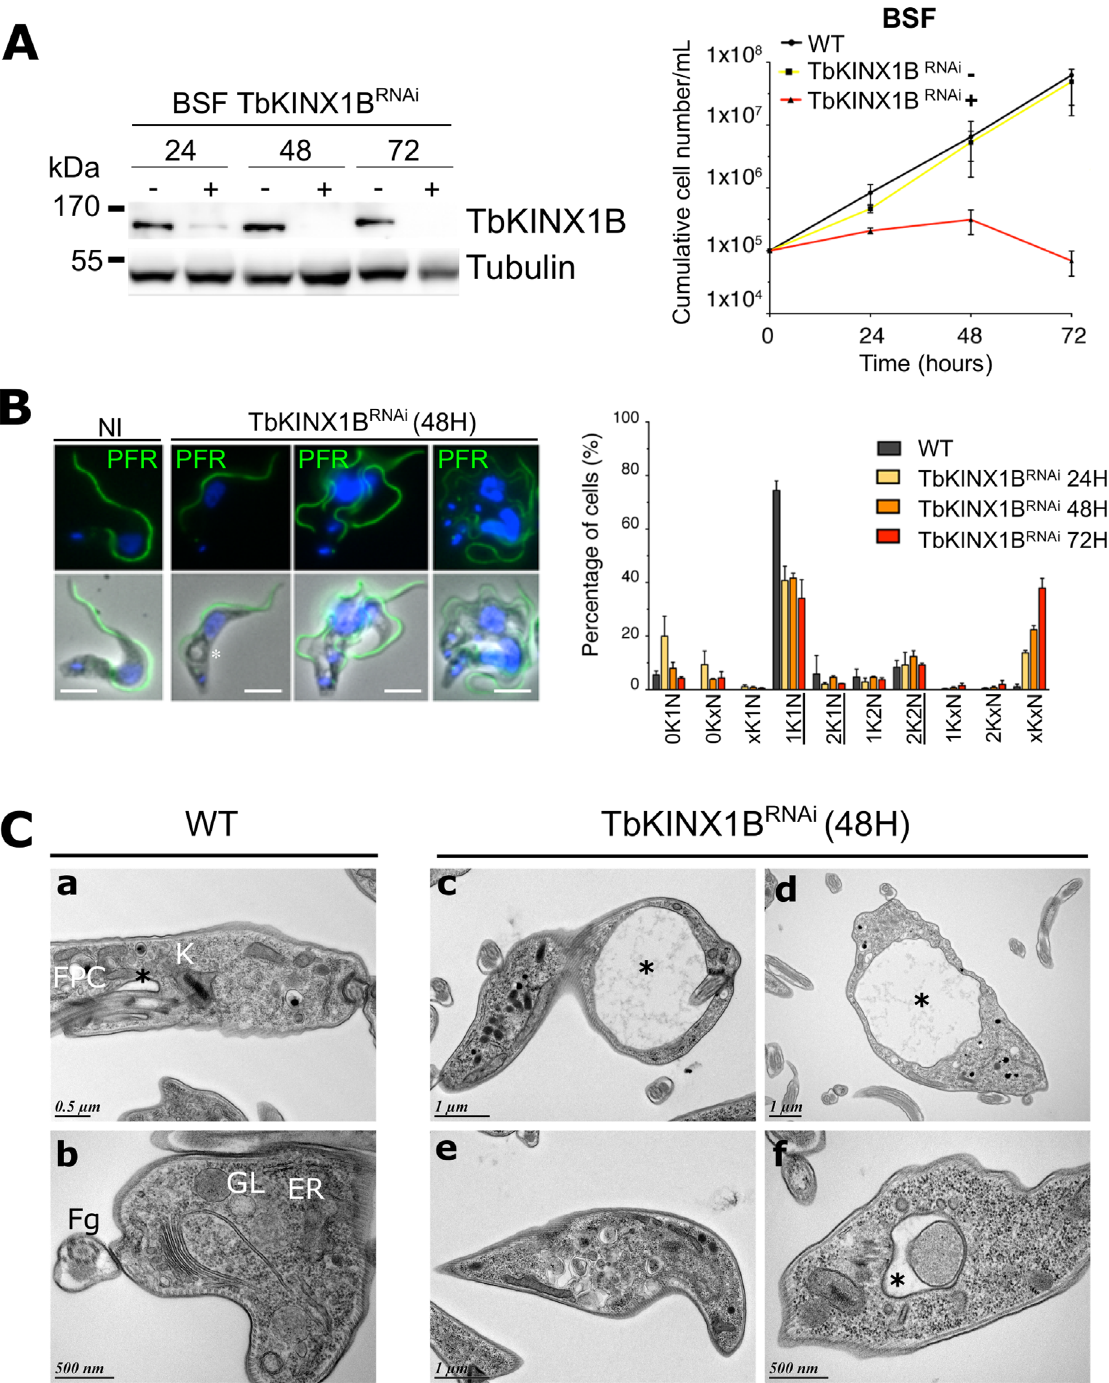
Figure 5. TbKINX1B is essential in bloodstream forms . A. Left panel, western blot of BSF whole cell protein extracts from TbKINX1B RNAi cell line in the absence ( (cid:3) ) or presence (+) of tetracycline at 24 h, 48 h and 72 h using anti-TbKINX1B, and anti-tubulin (TAT1) as a loading control. Right panel, down-regulation of TbKINX1B in BSF (+) inhibits cell growth after 48 h of induction, as compared to non-induced cells ( (cid:3) ) ( n = 3). B. Left panel, IFA micrographs of WT and of 48 h induced TbKINX1B RNAi BSF cell lines. Immuno fl uorescence shows that down-regulation of TbKINX1B leads to multi- fl agellated and multinucleated cells. Flagella were labelled with anti-PFR2 (green), and kinetoplasts and nuclei were DAPI-stained (blue). A large FP or vacuole is marked with an asterisk. Scale bars 5 l m. Right panel, quanti fi cation of cell division phenotypes in WT and in TbKINX1B RNAi cell lines after 24 h, 48 h and 72 h of induction. Normal phenotypes are underlined (200 cells, n = 3). C. Transmission Electron Microscopy (TEM) thin-sections of WT BSF and of TbKINX1B RNAi induced for 48 h. The structural organization of WT cells reveal well-de fi ned FP (black asterisk), FPC, Golgi (G), endoplasmic reticulum (ER), recycling endosomes (RE), glycosomes (GL), Flagellum (Fg), internal vesicles and kinetoplast (K) (a, b). TbKINX1B knock-down cells possess enlarged FP (black asterisk, c, d), with the disturbed endo-membrane organization (i.e., FP harboring dense material or enlarged) (e,